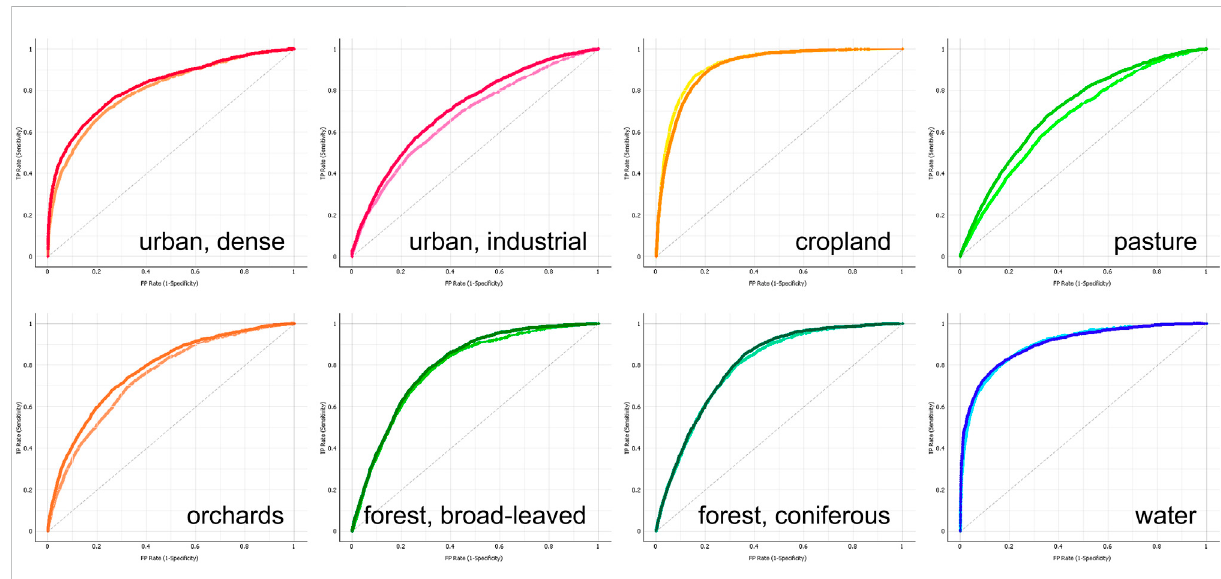
FIGURE 15 Receiver Operator Characteristic (ROC) curves selected land use and land cover classes. Dark tones represent the pseudo-polarimetric input data (S1q) and bright tones the dual-polarimetric products